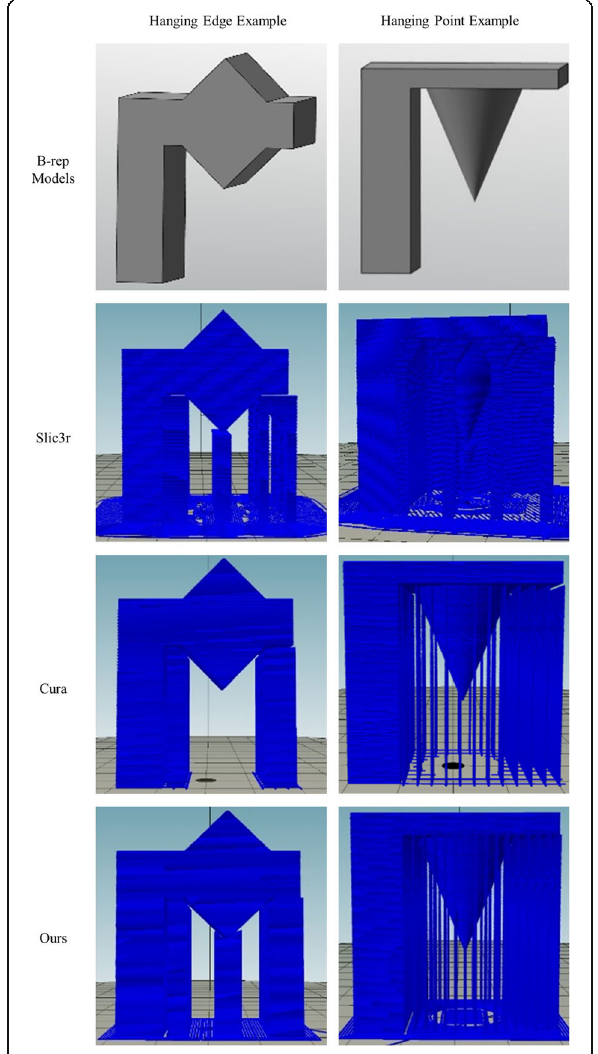
different methods